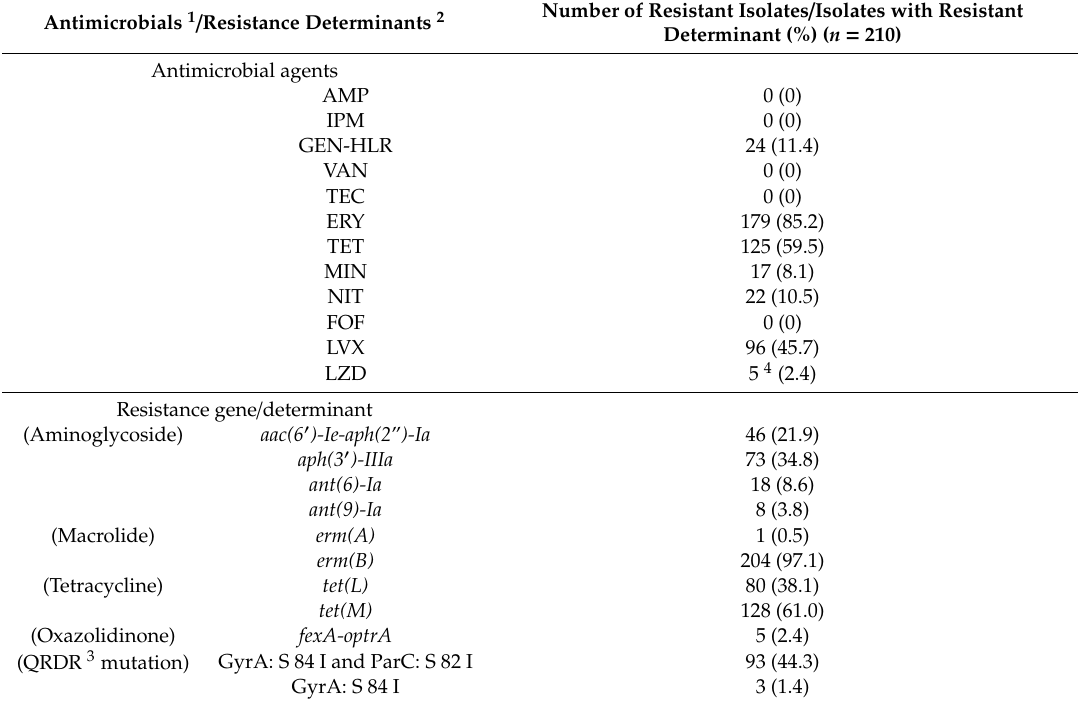
Table 1. Antimicrobial resistance and resistance determinants of E. faecalis clinical isolates in this study. Number of Resistant Isolates / Isolates with Antimicrobials 1 / Resistance Determinants 2